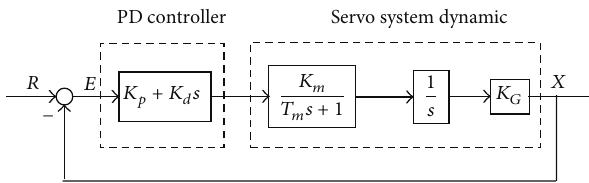
Figure 1: Closed loop control system model of a single axis with PD